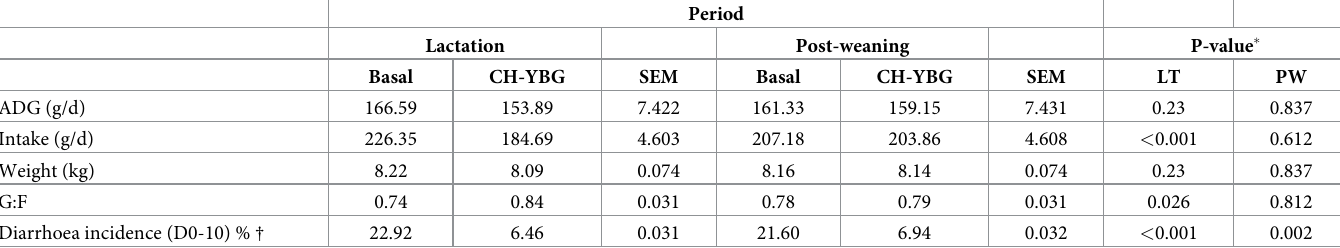
Table 3. Effect of supplementation of CH-YBG during gestation/lactation and/or post-weaning on pig growth performance and diarrhoea incidence for 10 days post-weaning. (least-square mean values with their standard error of means). Period Lactation